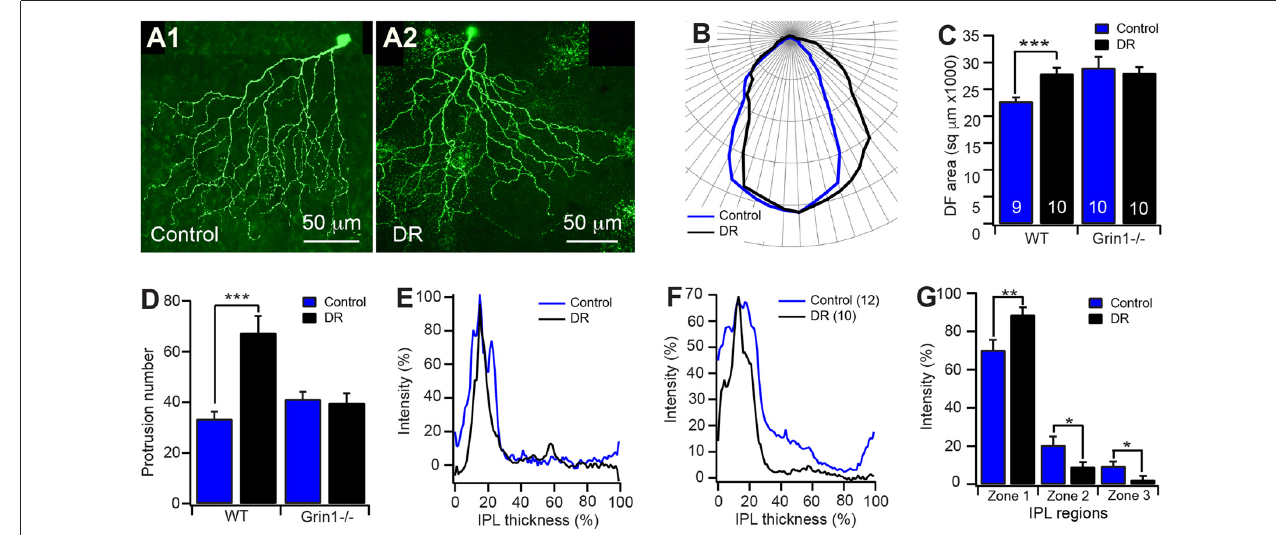
FIGURE 6 | Potential interplay of visual stimulation and NMDAR activity on the development of J-RGC dendrites. The dendritic pattern of J-RGCs of JamB-CreER:Thy1-YFP:Grin1-/- (Grin1-/-) and JamB-CreER:Thy1-YFP (WT) mice raised in constant darkness from birth to P30 was quantitatively analyzed. The results were compared with that of age and genetic background matched mice raised under cyclic light/dark conditions. (A) Representative maximum projections of confocal images of J-RGCs of P30 JamB-CreER:Thy1-YFP mice raised under cyclic light/dark conditions (A1) and constant darkness from birth (A2) . (B) The average polar plots of the DFs of the J-RGCs of JamB-CreER:Thy1-YFP mice (3 mice, 9 cells) raised under cyclic light/dark conditions (blue) and constant darkness (black, 3 mice, 10 cells). (C) The average sizes of DFs of J-RGCs of JamB-CreER:Thy1-YFP (WT) and JamB-CreER:Thy1-YFP:Grin1-/- (Grin1-/-, 3 mice, 10 cells for both control and DR) mice raised under cyclic light/dark conditions (control) and in constant darkness (DR). (D) The average number of dendritic protrusions of J-RGCs of JamB-CreER:Thy1-YFP and JamB-CreER:Thy1-YFP:Grin1-/- mice raised under cyclic light/dark conditions and in constant darkness. (E) Representative dendritic density distribution curves as a function of the IPL depth of J-RGCs of JamB-CreER:Thy1-YFP mice raised under cyclic light/dark conditions and in constant darkness. (F) Average dendritic density profile as a function of the IPL depth of J-RGCs of JamB-CreER:Thy1-YFP mice raised under cyclic light/dark conditions and in constant darkness. (G) The average dendritic density distribution of the J-RGCs in three IPL zones of JamB-CreER:Thy1-YFP mice raised under cyclic light/dark conditions and in constant darkness. ∗ P < 0.05; ∗∗ P < 0.01; and ∗∗∗ P <